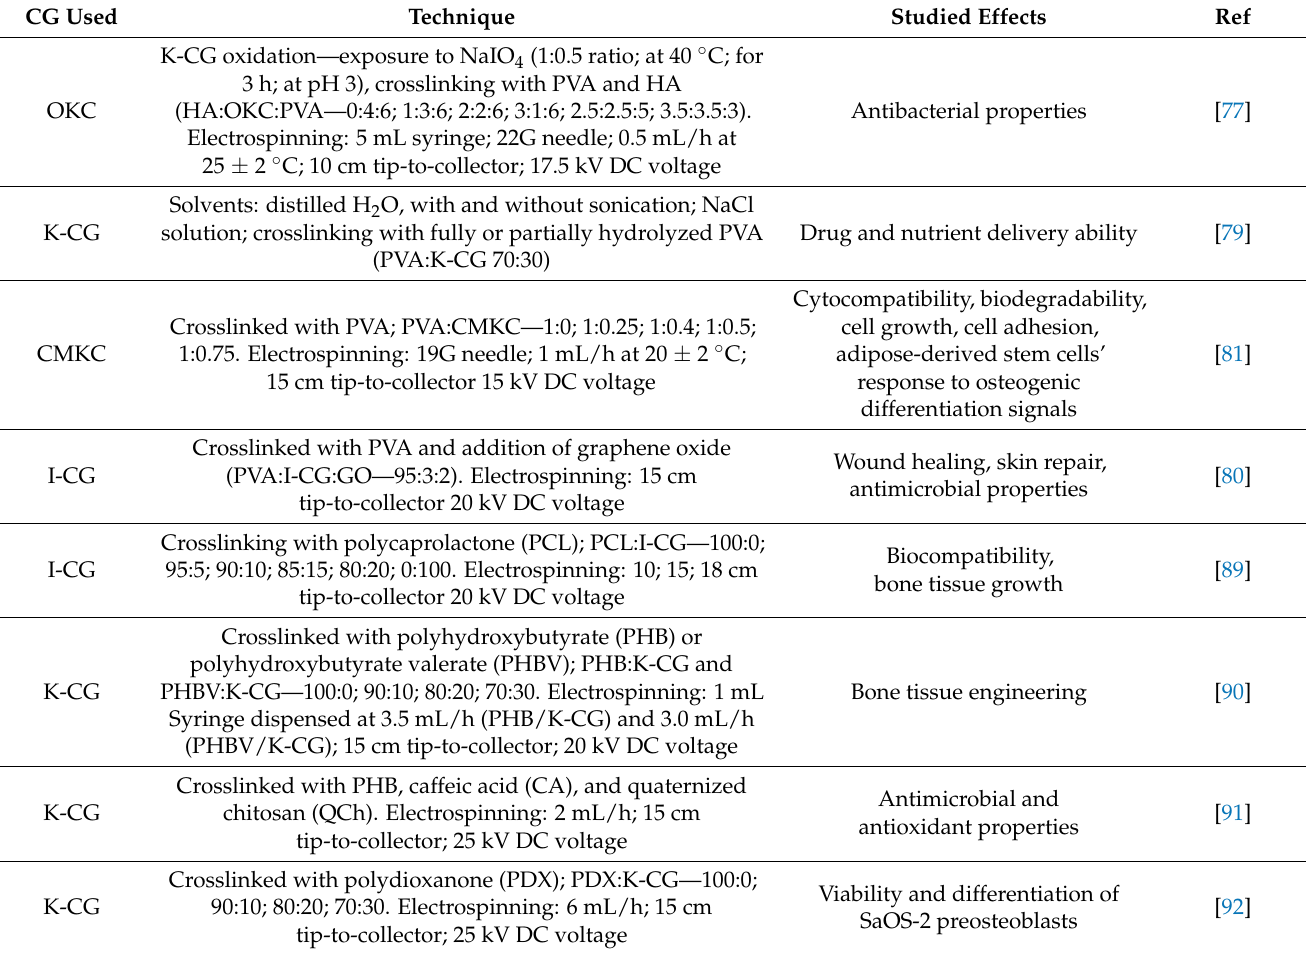
Table 2. Biological effects of various types of carrageenans.